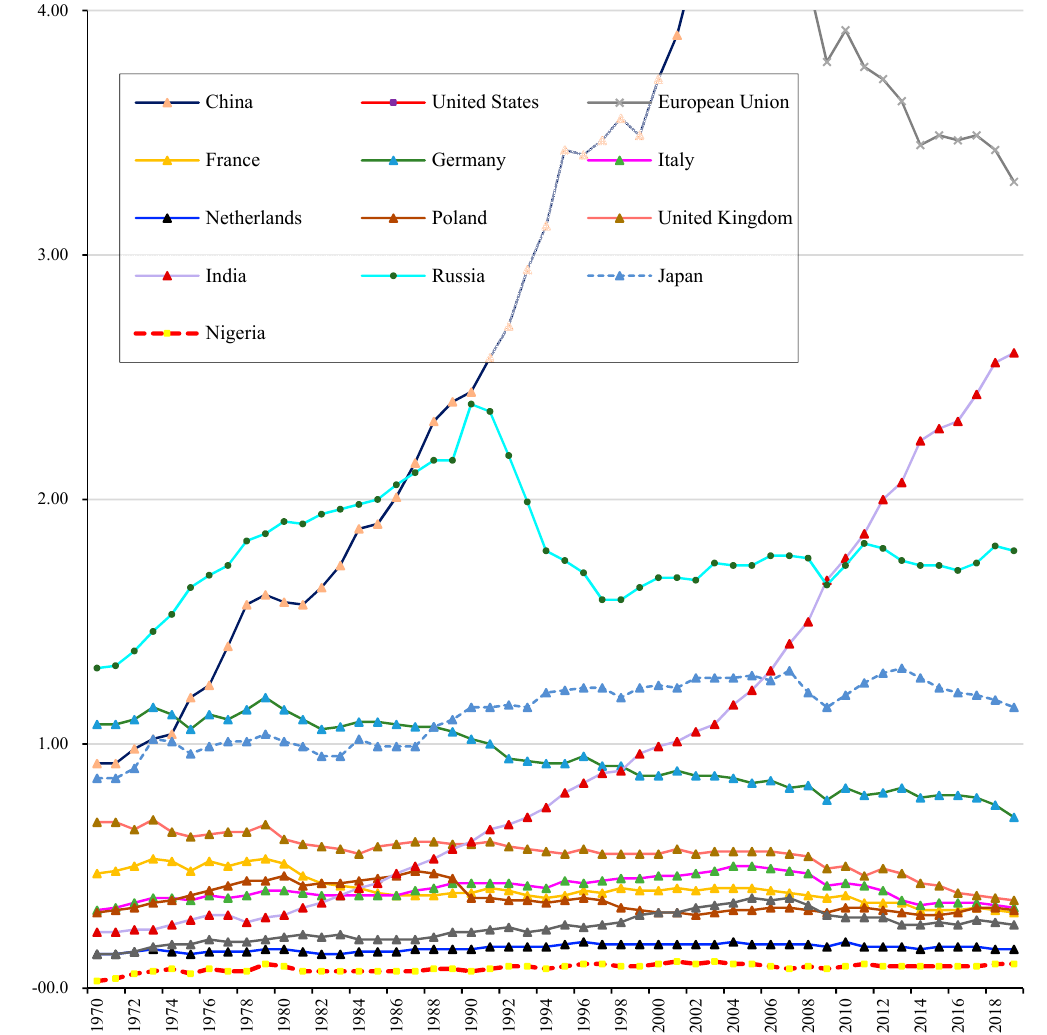
Figure 3. Carbon-dioxide (CO 2 ) emissions from 1970 to 2019 in Nigeria and other countries.